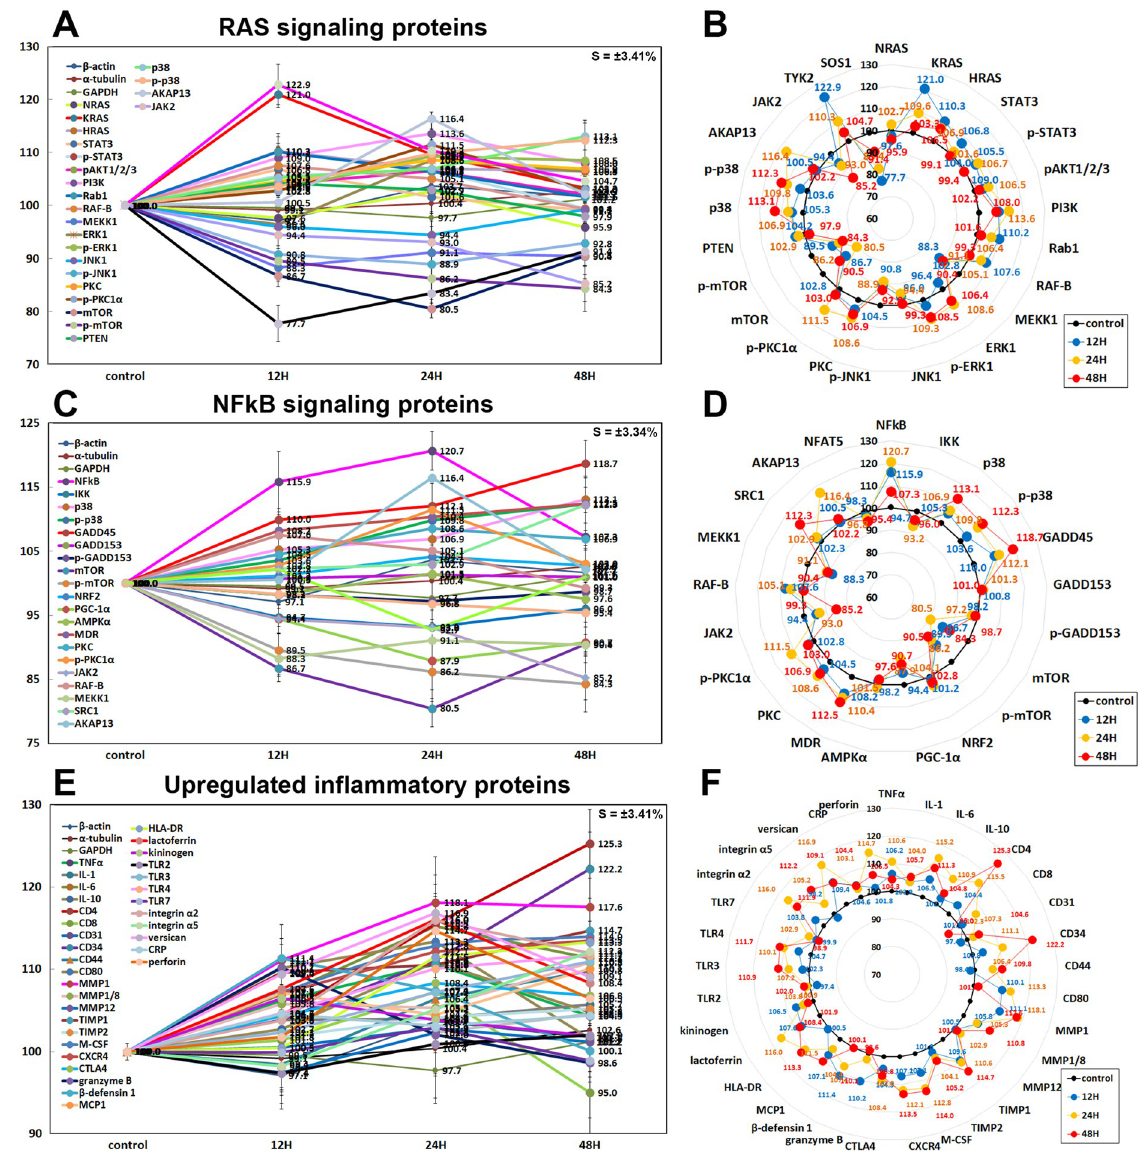
Fig 11. Expression of RAS signaling proteins (A and B), NFkB signaling proteins (C and D), and upregulated inflammatory proteins (E and F) in 10 μ g/mL PTX-treated RAW 264.7 cells as determined by IP-HPLC. Line graphs, A, C, and E show protein expression on the same scale (%) versus culture time (12, 24, or 48 h), whereas the star plots (B, D, and F) show the differential expression levels of the proteins at 12, 24, or 48 h after PTX treatment on the appropriate scales (%). The thick black line, untreated controls (100%); the blue, yellow, and red dots show differential protein levels after PTX administration for 12, 24, or 48 h,